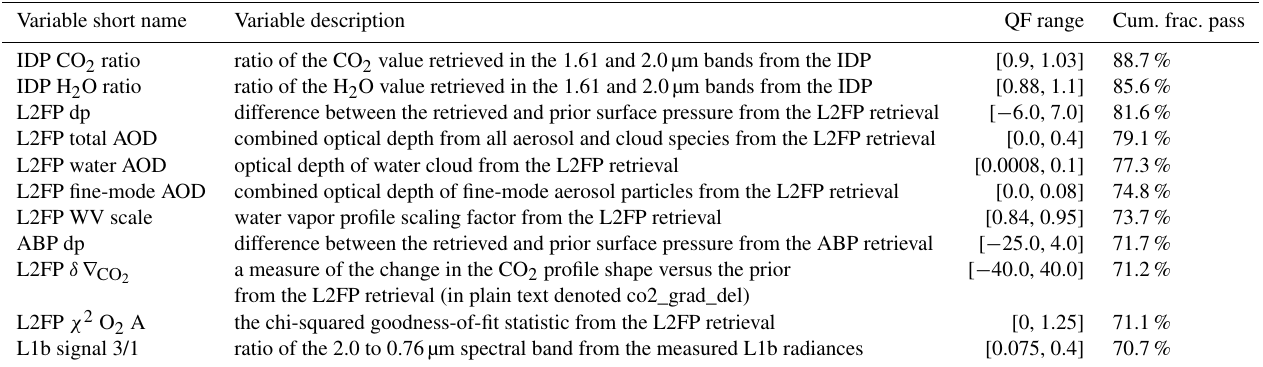
Table 2. Variables and thresholds used for quality filtering in the OCO-3 simulations for nadir–land. The cumulative fraction of passing scenes is also given. Note that the need for the water vapor scale factor (L2FP WV scale) is likely due to a recently discovered bug in the simulator code that introduced a mismatch between the vertical profile in the scene and meteorology files.